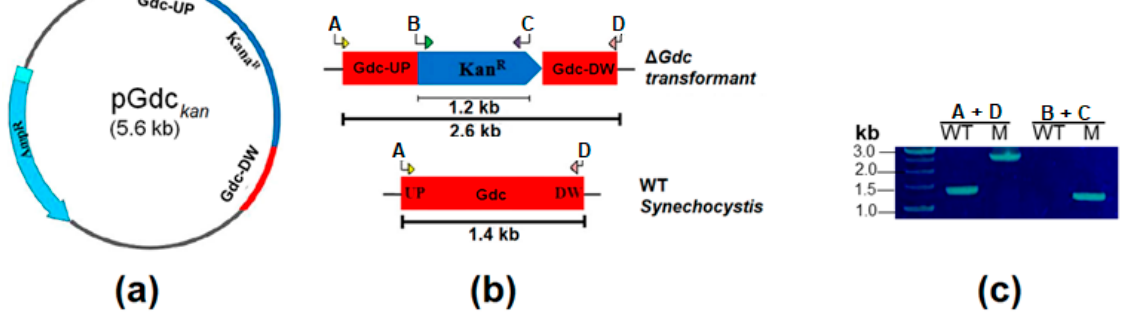
Figure 2. Inactivation of Gdc in Synechocystis . ( a ) Design and plasmid construction for Gdc interrupted by a kanamycin antibiotic-resistant cassette and cloning into a pGEM-T easy vector. AmpR stands for the ampicillin-resistant cassette in pGEM-T easy vector backbone. ( b ) Simplified scheme of the wild-type (WT) Synechocystis and of the Synechocystis mutant (M) strain with the inactivated Gdc . Primers used for the performance of PCR are indicated (arrows labelled ‘A’–‘D’), with the expected PCR product sizes shown as bars beneath both maps. ( c ) Confirmation of the complete segregation of the mutant strain through PCR amplification. Lane WT stands for the wild-type, while lane M stands for the Δ Gdc strain, with primer positions as indicated in (b) .